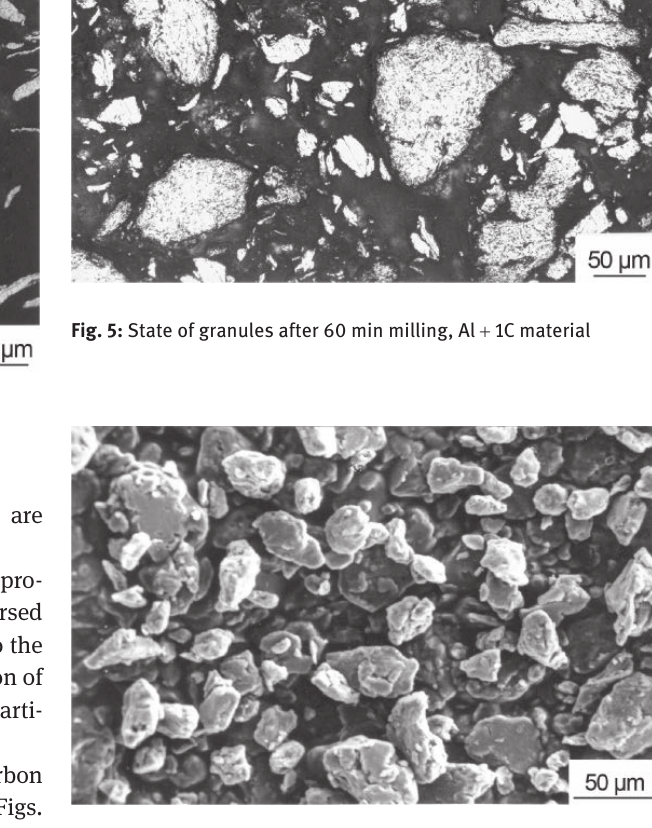
Fig. 6: Shape of granules after 240 min milling of Al + 1C material